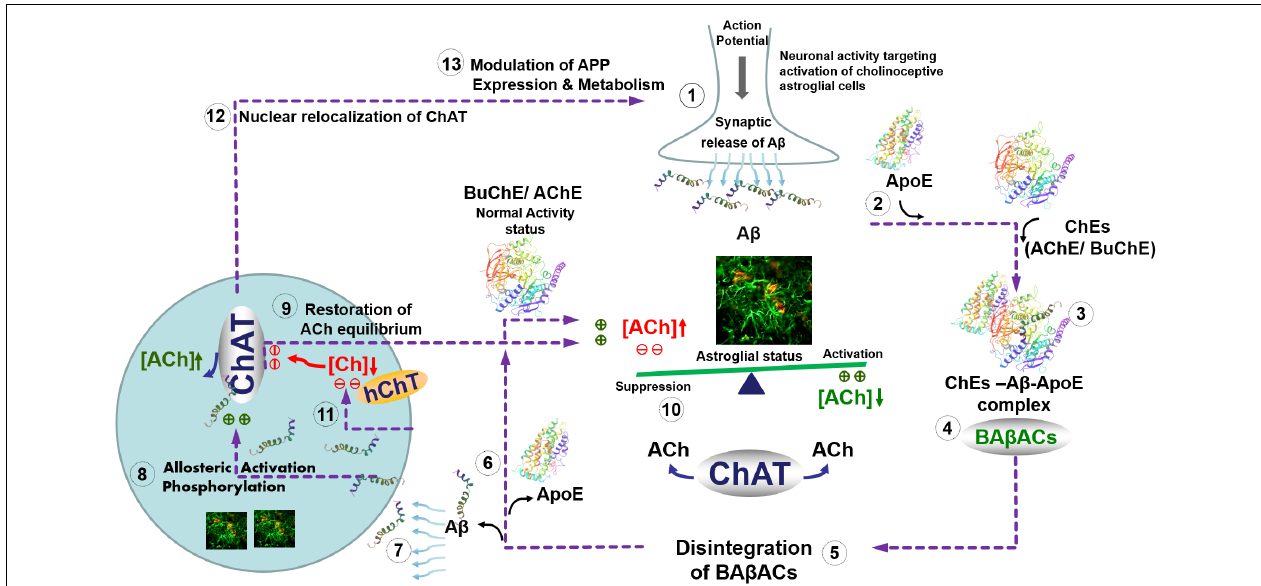
FIGURE 6 | Hypothetical regulatory pathway of the synaptic and extrasynaptic cholinergic signaling by A β peptides. ( 1 ) Neuronal activity demanding activation of cholinoceptive astroglial cells initiate an action potential-synchronized release of the intraneuronal A β peptides (Cirrito et al., 2005), e.g., from cholinergic neurons (Baker-Nigh et al., 2015) into the interstitial fluid. ( 2 ) Simultaneous release of ApoE by astroglia may facilitate the interaction of the released A β peptides with the soluble cholinesterases (ChEs) ( 3 ), leading to the formation of BA β ACs. Binding of A β peptides to the ChEs leads to an increased intrinsic catalytic rate of these enzymes, plausibly through allosteric modulation of their tertiary structures. ( 4 ) The hyperfunctional BA β ACs will then effectively lower the extrasynaptic acetylcholine (ACh) and thus shifts its equilibrium state, which is maintained by the soluble ACh-synthesizing enzyme choline acetyl-transferase (ChAT) (Vijayaraghavan et al., 2013). The lowered ACh will result in a heightened functional status of astroglial cells, allowing them to perform the intended task. ( 5 ) Cellular re-uptake of A β peptides will then reduce the levels of A β peptides, leading to the disintegration of BA β ACs. ( 6 ) The enzymatic activity of ChEs will then return to a relatively dormant state (Darreh-Shori et al., 2011a). ( 7 ) Cellular reuptake of A β by astrocytes and cholinergic neurons will simultaneously augment intracellular ACh production, ( 8 ) either through direct allosteric activation of ChAT by A β peptides (as shown in the current study) and/or by inducing a hierarchical phosphorylation of ChAT (Dobransky et al., 2003). ( 9 ) This will lead to the additional release of ACh by astrocytes and cholinergic neurons. ( 10 ) The additional release of ACh together with in situ resynthesis of ACh by soluble ChAT, effectively normalize the initial steady-state balance of ACh levels, and thereby allow the astroglial cells to regain their initial activity status (Malmsten et al., 2014). ( 11 ) The increasing intracellular A β will then inhibit reuptake of choline into the cells by inhibiting the high-affinity choline transporter (Cuddy et al., 2017) restricting the amount of substrate (choline) for production of intracellular ACh by the hyperactivated ChAT. ( 12 ) Increased levels of intracellular A β will also induce translocation of a membrane-bound 82kDa variant of ChAT to the nucleus (Winick-Ng et al., 2016) where ( 13 ) it will modulate gene expression and metabolism of the amyloid precursor protein (APP) (Albers et al., 2014). This will restore the overall balance of ACh homeostasis in the brain ( 1 ). In Alzheimer’s disease, this ACh homeostasis is disturbed via reduced cellular A β reuptake by abnormal levels of ApoE protein (Darreh-Shori et al., 2011b), which forms strong complexes with A β peptides (Kumar et al., 2016a). This not only reduces the clearance of A β but also forces abnormal accumulation of BA β ACs leading